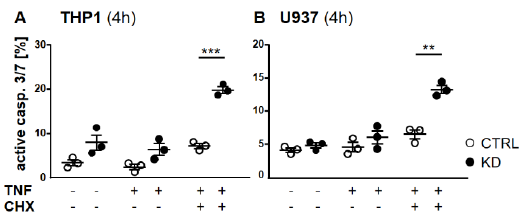
Figure 5. Depletion of YB-1 led to effector caspase activation. ( A , B ) Flow cytometry analyses of caspase-3 / 7 activation in THP-1 ( A ) and U937 cells ( B ). Cells were treated with or without TNF (20 ng / mL) alone or together with cycloheximide (10 ng / mL) for 4 h. Cells were harvested and stained for caspase-3 / 7 activation. Error bars specify the standard error mean (SEM) of at least three experiments. Statistical significance was calculated by unpaired t -test, n = 3. Data represent the mean ± SEM. ** p < 0.01, *** p ≤ 0.001.